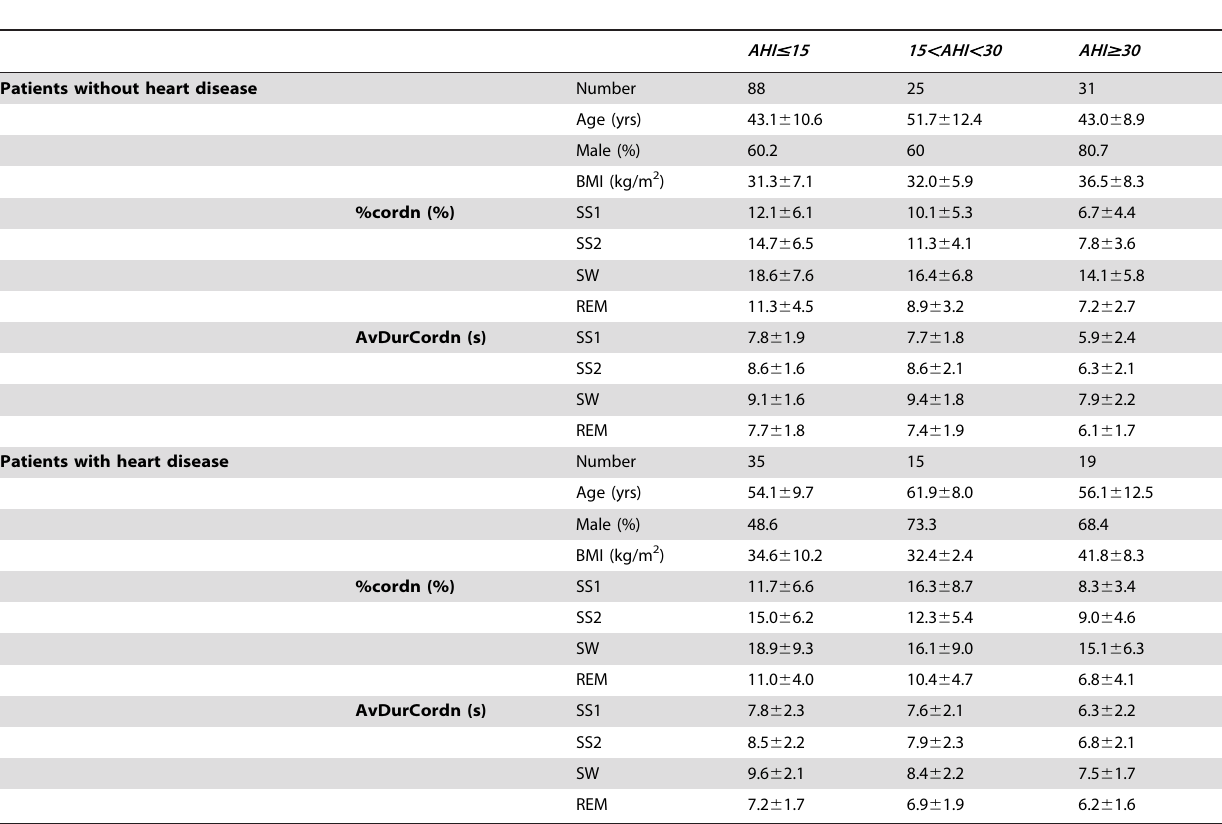
Table 1. Percentage of coordination (%cordn) and duration of coordinated epochs (AvDurCordn) for different AHI groups and sleep stages using abdominal signal (ABDO) for patients with and without heart